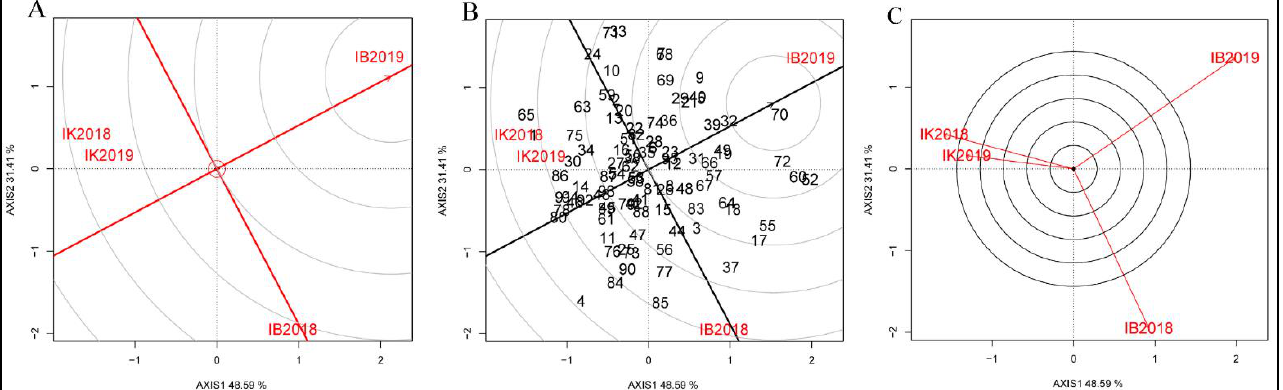
Figure 5. Ranking environments and genotypes based on both mean and stability relative to an ideal genotype. ( A ) Ranking environments with respect to an ideal environment. ( B ) Ranking genotypes with respect to an ideal genotype. ( C ) Relationship among tested environments.